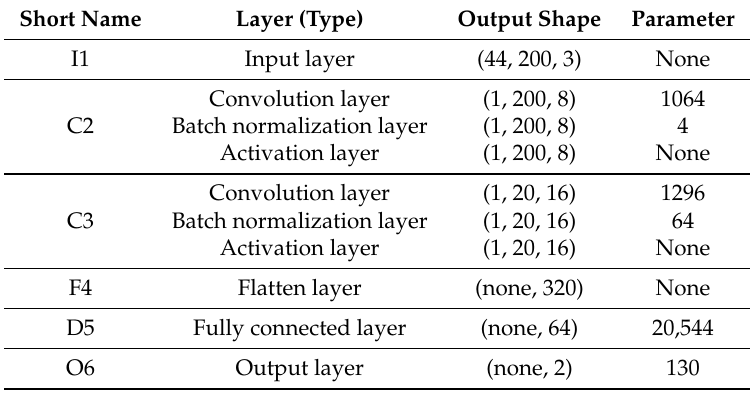
Table 1. The output matrix size and network parameters of each layer of SCNN.